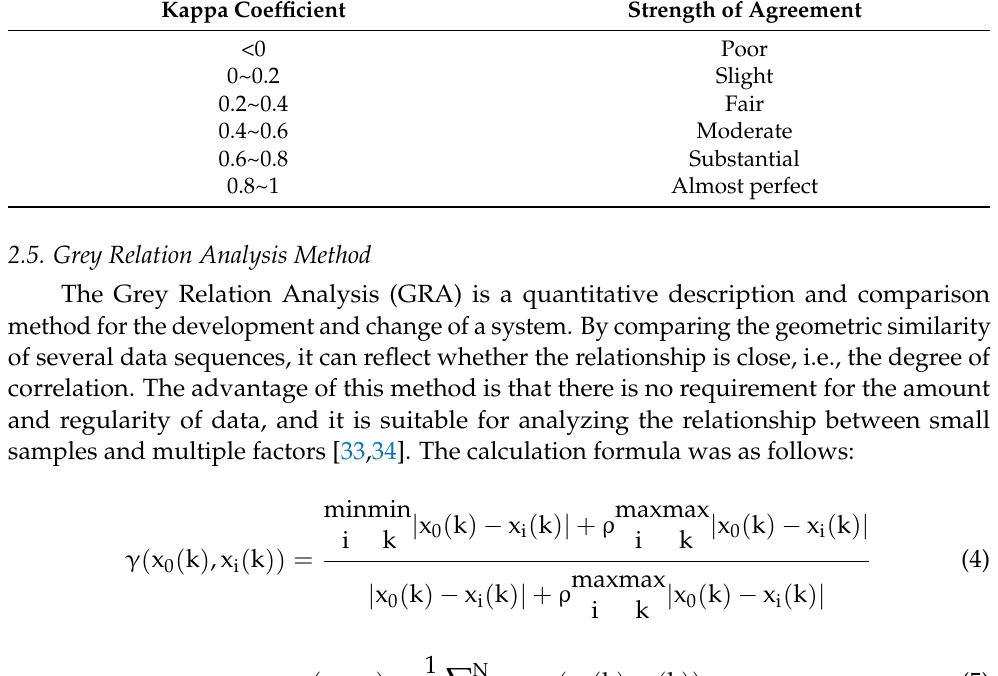
Table 3. Kappa coefficient and classification accuracy comparison table. Kappa